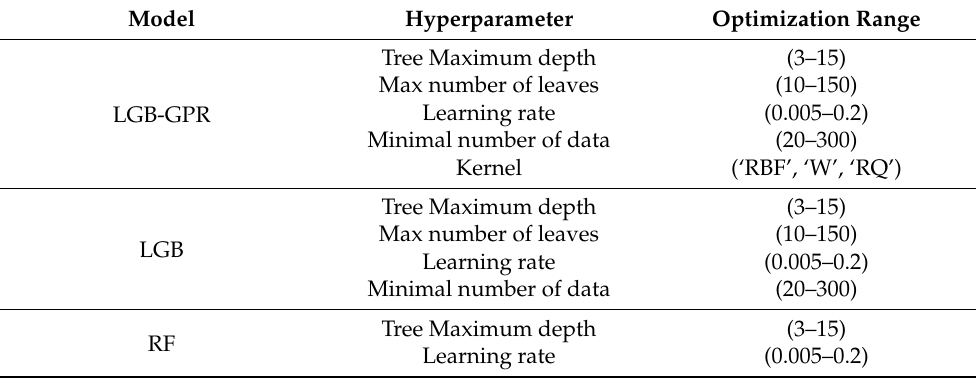
Table 1. Model hyperparameter optimization